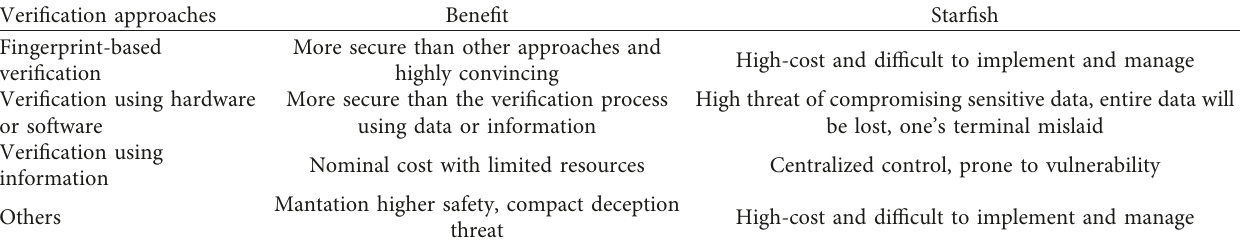
Table 1: Verification approaches with their features.